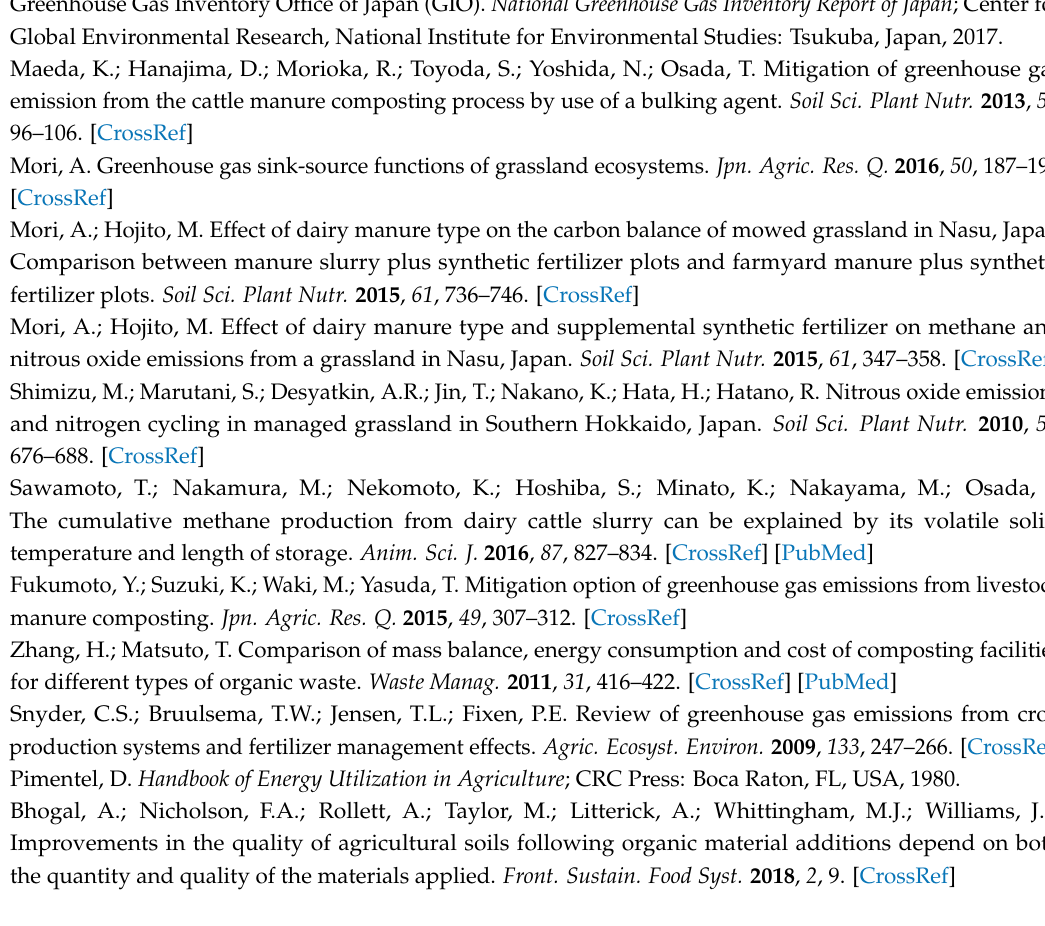
Table S1: Calculation bases of greenhouse gas